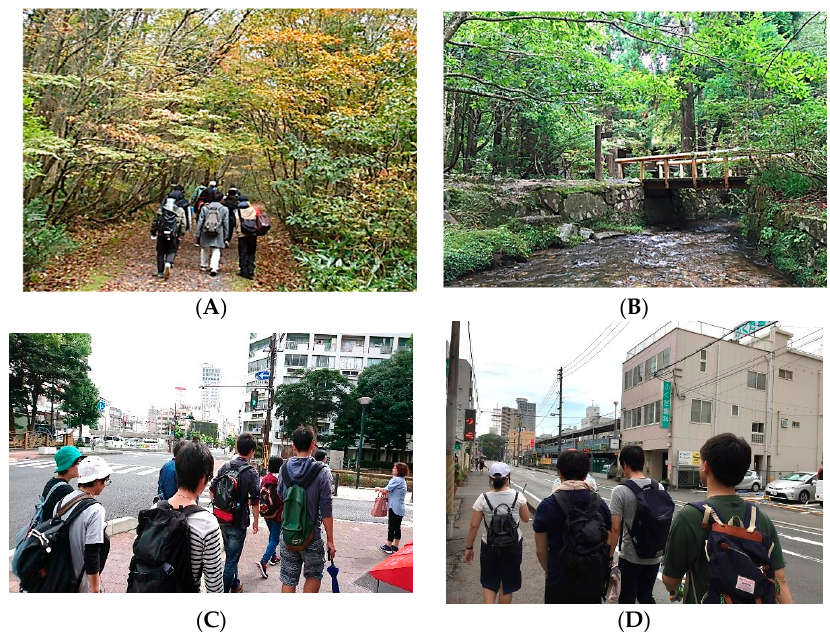
Figure 1. ( A , B ) Pictures of the forest walk. ( C , D ) Pictures of the urban walk.